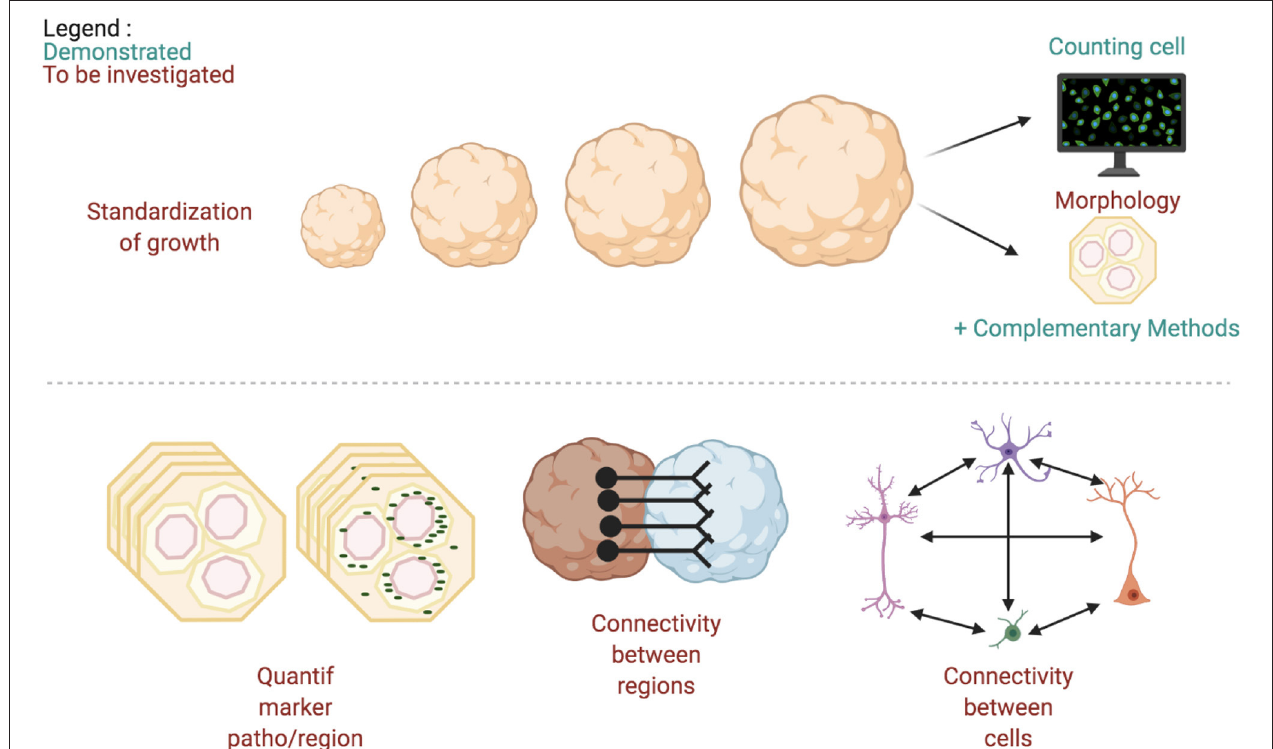
FIGURE 7 | Quantitative and morphological expected tools to analyze images of 3D brain